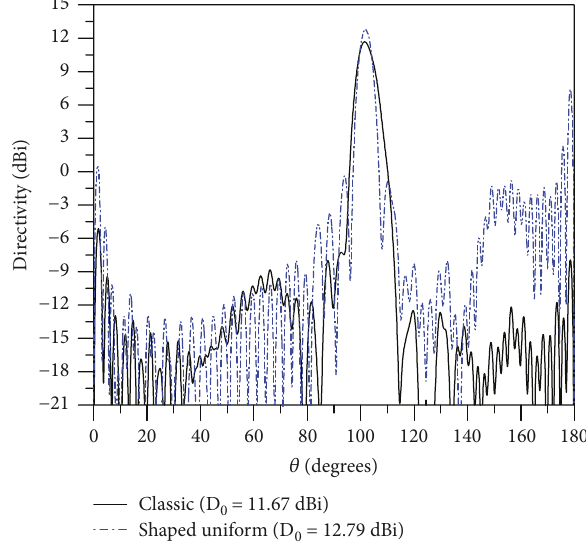
Figure 7: MoM/MMT radiation patterns of the classical and shaped ADE antennas.